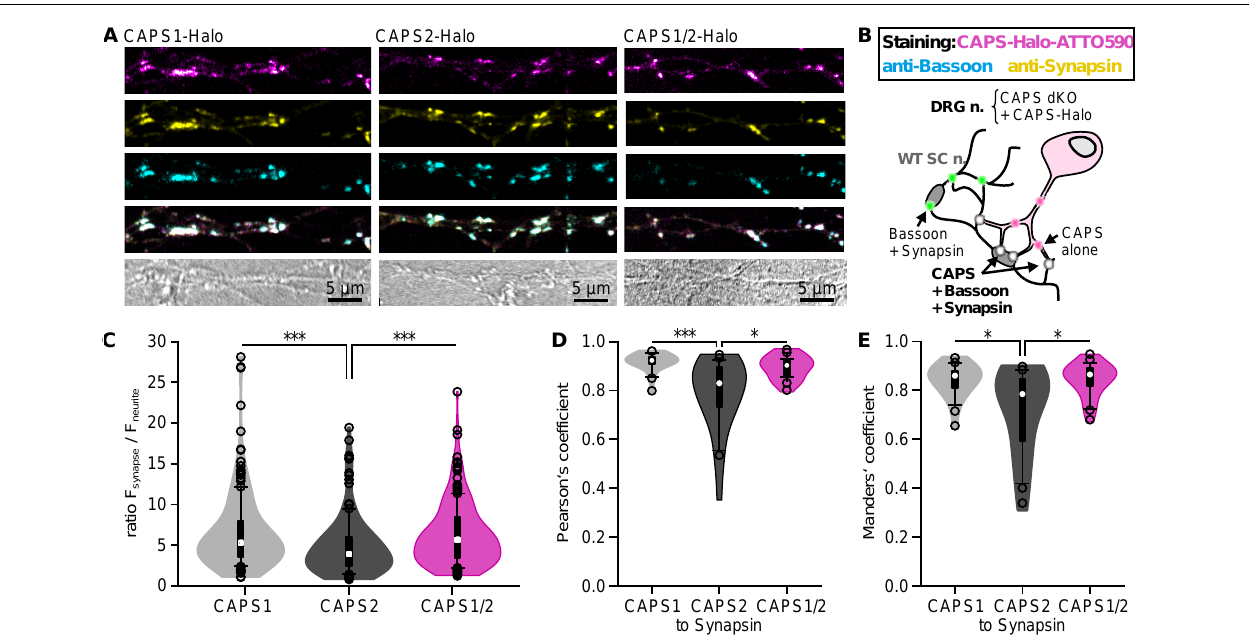
FIGURE 5 | The N-terminal sequence of CAPS1 determines its pre-synaptic localization. (A) Representative neurites of DRG CAPS dKO neurons transfected with CAPS1-, CAPS2b-, or CAPS1/2 chimera-Halo. On DIV2 SC neurons were added to the cultures. Halo ligand CA-ATTO590 labeling (magenta) on DIV6. On DIV9 cells were fixed and immuno-labeled with specific antibodies against bassoon (cyan) and synapsin (yellow). Note that the lookup table in the upper row (CAPS-Halo) is magenta hot, with white representing the highest fluorescence. This lookup table was not used in the merged image in the third row to correctly represent co-localization. All images for individual channels are scaled to the same values. (B) Schematic representation of the experimental design. Green dots indicate homotypic synapses from SC neurons marked by a positive staining of synapsin and bassoon, while co-localization of CAPS-Halo constructs with synapsin and bassoon are visualized as white dots. (C) Violin plot of CAPS-Halo normalized fluorescence intensity ratio for all three constructs. Synaptic CA-ATTO590 fluorescence intensity was normalized to the signal in adjacent areas of the neurites. n = 182, n = 148, and n = 173 synapses for CAPS1, CAPS2b, and CAPS2/1 chimera, respectively; N experiment = 3; *** p < 0.001 one-way ANOVA on ranks with Dunn’s post hoc test. (D) Co-localization of CAPS1, CAPS2b, and CAPS1/2 with synapsin was measured on isolated synapses of DRG neurites and quantified using the Pearson’s correlation coefficient. n neurites = 24; N = 3 for all constructs; * p = 0.010 or *** p < 0.001 one-way ANOVA on ranks with Tukey post hoc test. (E) Manders’ overlap coefficients for the proportion of CAPS1, CAPS2b, and CAPS1/2 immunoreactivity in synapsin-positive locations. n neurites = 24; N experiment = 3 for all constructs; * p = 0.014 for CAPS1 and CAPS2 or * p = 0.010 for CAPS1/2 and CAPS2 one-way ANOVA on ranks with Tukey post hoc test. Box plots are superimposed on the violin plots. Median is shown as white dot while outliers are represented as empty